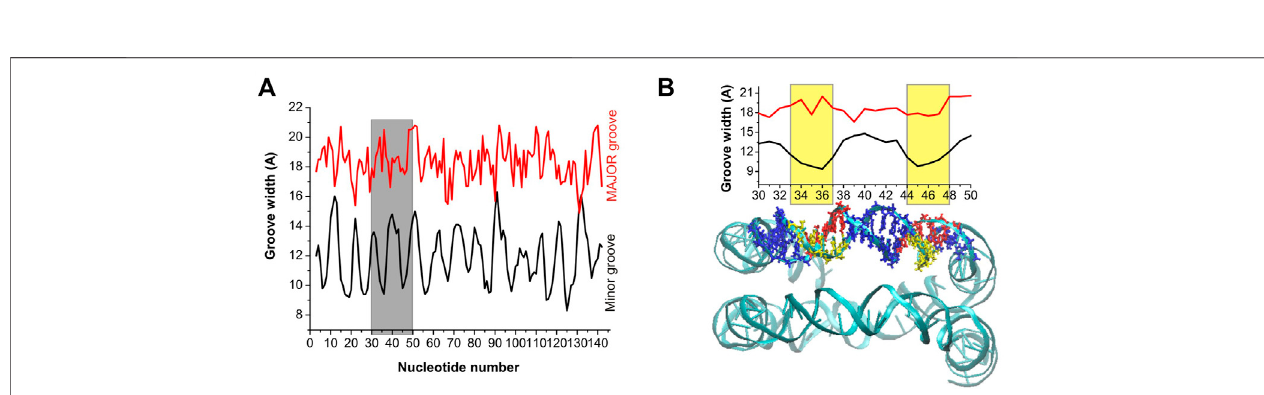
FIGURE 5 | (A) Minor and major groove width across the nucleosomal DNA. (B) Expansion of the grey band portion of Panel (A) , and a representation of the nucleosomalDNAinwhichthebasepairsincludedinthewidthcalculationarehighlightedwithastickrepresentation.Theyellowbands,inthegroovewidthplot,markthe region of DNA with the narrowest minor groove, and the corresponding base pairs are highlighted in yellow and red in the DNA snapshot.